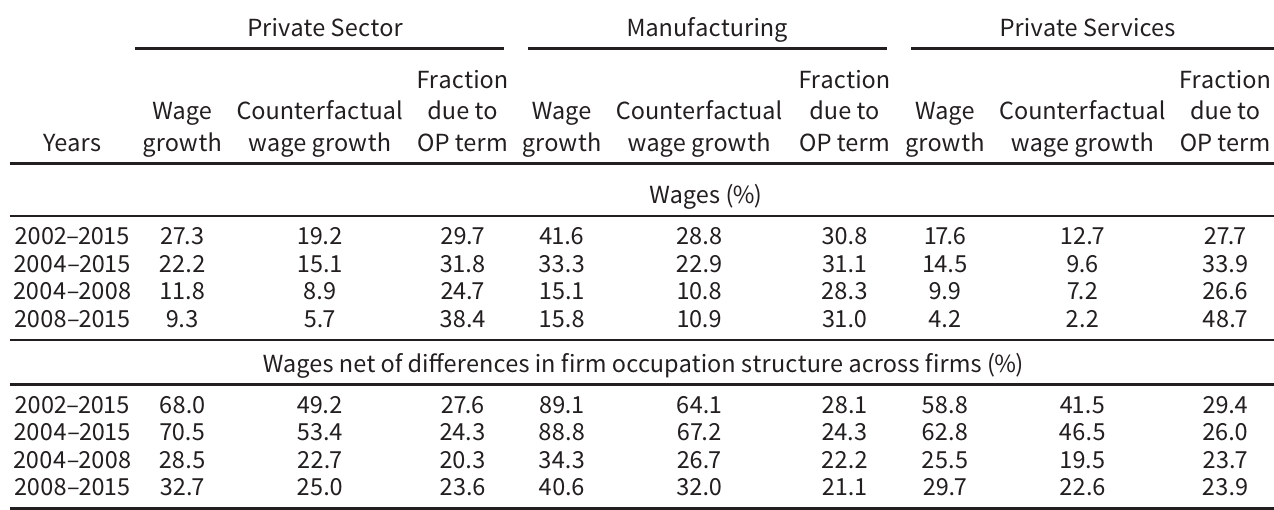
Figure 5 plots the series for the actual aggregate wage against the artificial series obtained by compounding the counterfactual growth rates using as a base the year when the OP term starts increasing – 2002 in the manufacturing sector and 2004 in the service sector and nonagricul- tural business sector. Percentage contribution of the OP term to aggregate wage growth in different periods Private Sector Manufacturing Private Services Fraction Fraction Fraction Wage Counterfactual due to Wage Counterfactual due to Wage Counterfactual due to Years growth wage growth OP term growth wage growth OP term growth wage growth Wages (%)